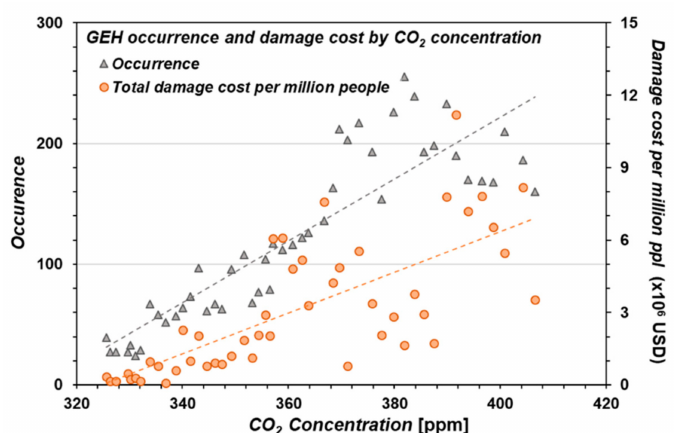
Figure 8. Correlation between CO 2 concentration and geotechnical engineering hazards, in terms of occurrence and total damage per million people. Reproduced with permission from the Centre for Research on the Epidemiology of Disasters (CRED), Emergency Events Database (EM-DAT); published by the Universit é catholique de Louvain (UCL) [67] and permission from Ed Dlugokencky and Pieter Tans, Trends in atmospheric carbon dioxide (www.esrl.noaa.gov / gmd / ccgg / trends / ); published by the National Oceanic & Atmospheric Administration (NOAA)